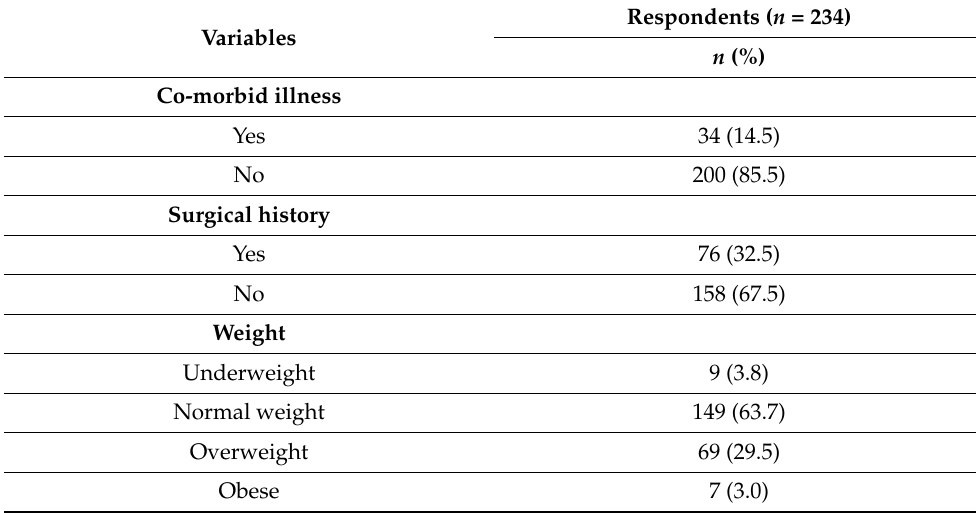
Table 2. Medical Factors of the respondents.